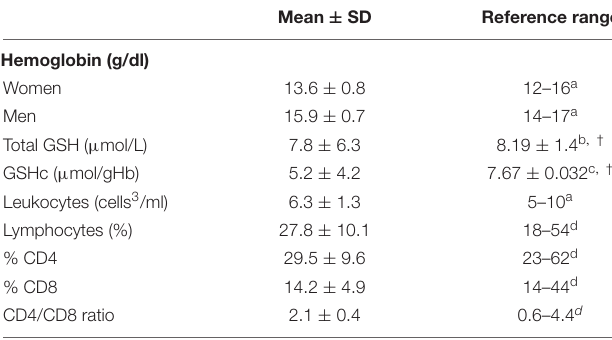
TABLE 3 | Hematological and biochemical parameters ( n =